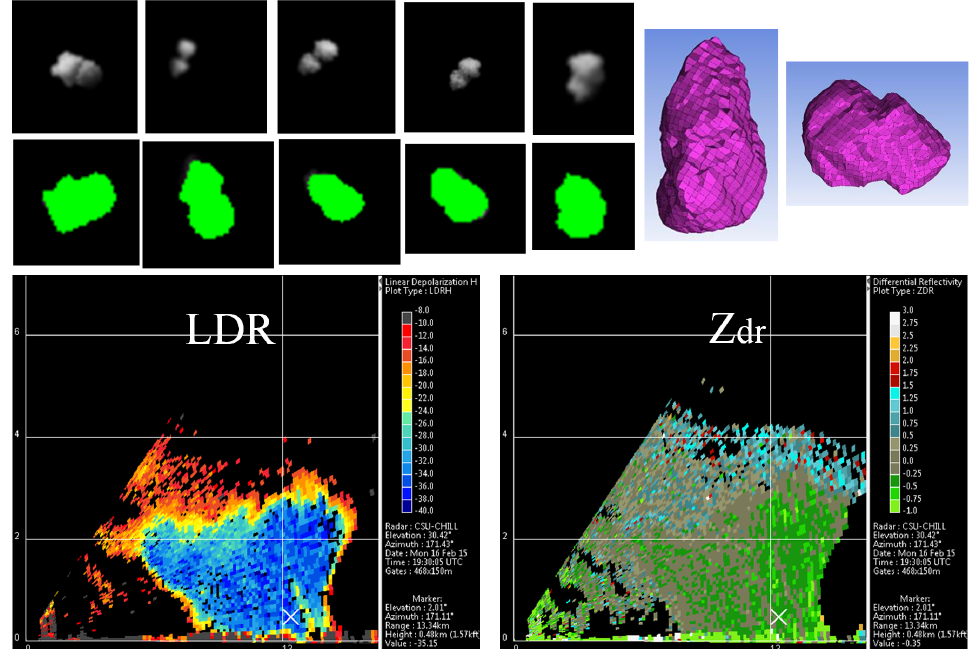
Figure 22. Illustrative results of MoM-SIE scattering calculations based on the MASC images captured at the MASCRAD Field Site during the unusual winter graupel shower event on 16 February 2015 and the resulting 3D shape reconstruction, in comparison with the corresponding CSU-CHILL radar RHI plots of LDR and Z dr at the same time. Results: MASC/MoM-SIE: ε r = 1.275 − j0.0003, LDR = − 36 dB, Z dr = − 0.15 dB; CHILL Radar: LDR = − 35 dB, Z dr = − 0.21 dB, at the 12.92-km range.